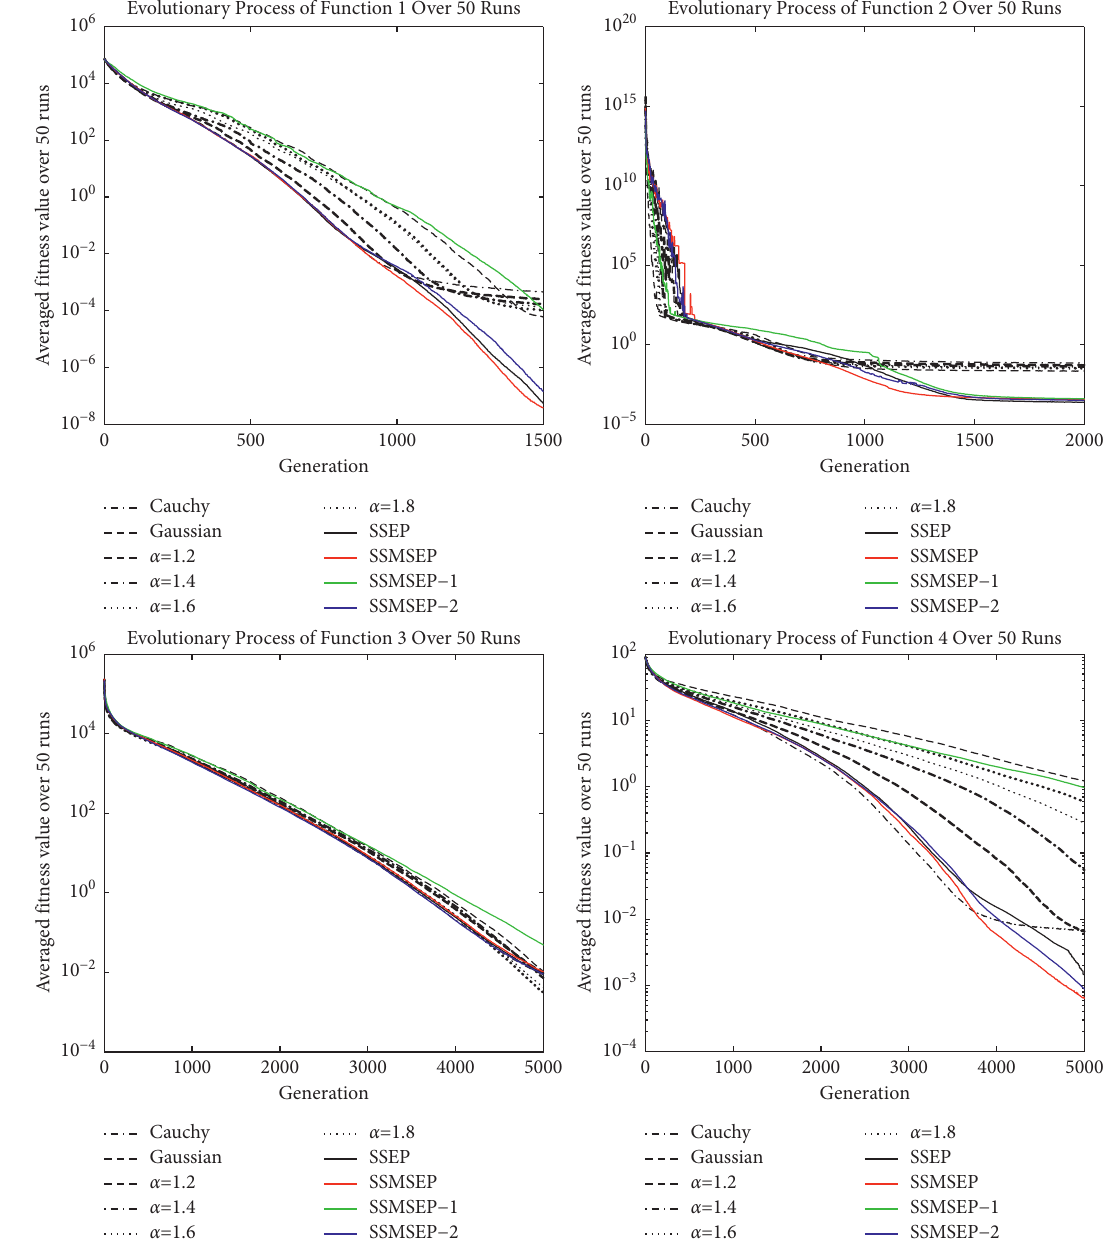
Figure 1: Evolutionary process of f